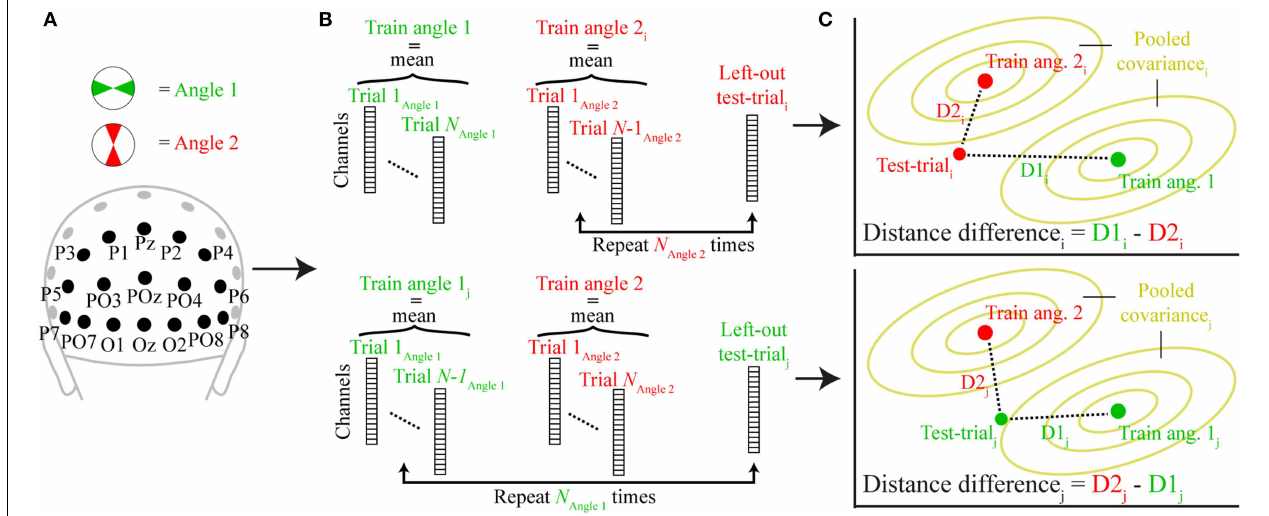
FIGURE 3 | A schematic representation of the trial-wise Mahalanobis distance analysis. (A) The signal for two orthogonal angle bins (angle 1 and angle 2) was extracted from all posterior channels at a specific time point. (B) A single trial was either removed from angle 2 (top; test-trial i ) or angle 1 (bottom; test-trial j ) and the mean signal for each angle condition of all other trials comprised the training set (train angle 1, train angle 2). (C) The Mahalanobis distances of the left-out test-trial to train angle 1 (D1) and train angle 2 (D2) illustrated in two-dimensional space. The pooled covariance is computed from the training data. When the test trial belongs to angle bin 2, D2 i is subtracted from D1 i (top), when it belongs to angle bin 2, D1 j is subtracted from D2 j (bottom). This procedure is repeated for each trial and time-point and the resulting distance differences are averaged across all trials.